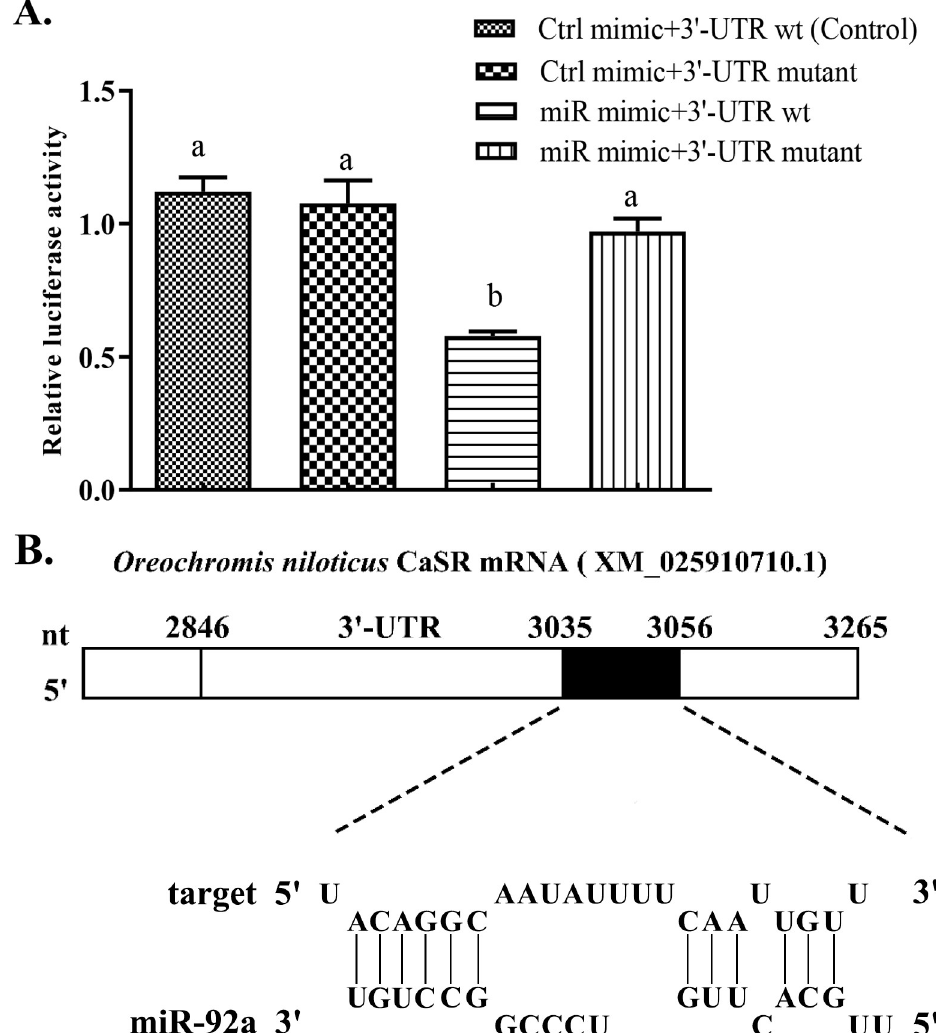
Fig 2. Verification of binding between miRNA and its potential target gene. (A) Validation of miRNA binding to 3 0 UTR of potential target gene using dual luciferase reporter system. HEK-293T cells in 12-well plates were co- transformed with pGL-CaSR 3 0 UTR (3 0 UTR-wild type) or pGL- CaSR (3 0 UTR-Mutant) and miRNA mimic (miR mimic) or miRNA negative control (Ctrl mimic) using Lipofectamine 2000 transfection reagent. Luciferase activity was determined based on fluorescence. (B) Analysis of binding site between miR-92a and Oreochromis niloticus CaSR (XM_025910710.1): 5 0 -end of miR-92a can pair with 3048 bp–3056 bp position at the CaSR 3’-UTR. Compensation binding site at 3 0 -end of miR-92a enhances its binding stability with 3 0 -UTR of CaSR . Different lowercase letters indicate significant differences among experimental groups (Duncan’s multiple comparison; P < 0.05).